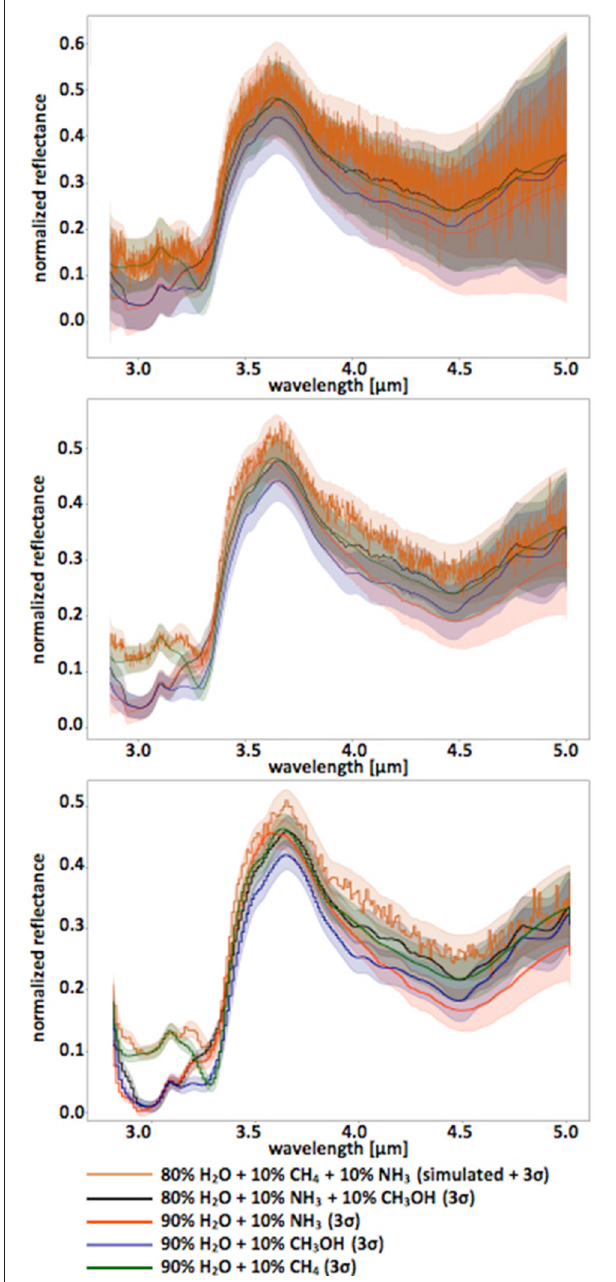
FIGURE 5 | Simulated spectra for various ice mixtures relevant to mid-sized TNO surface compositions (water as themajor ice species with contributions from methane, ammonia and methanol ice), focused on the 3–5 micron wavelength range, for high-, medium-, and low-spectral resolution (from top to bottom, respectively). The simulated signal is shown for one mixture only for clarity. Shaded areas show the 3- σ detection limits corresponding to the simulated signal-to-noise